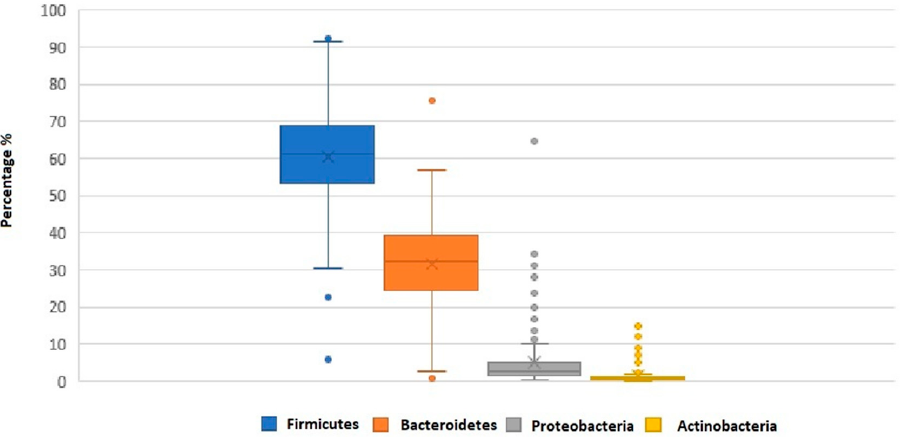
Figure 2. Box plot showing the relative abundance for the dominant phyla determined by the Global Alignment Sequence Taxonomy assignments. The boundary of the box closest to zero indicates the 25th percentile, the line within the box represents the median, and the boundary of the box farthest from zero indicates the 75th percentile. Whiskers above and below the box indicate the 10th and 90th percentiles. The arithmetic mean is indicated by x. Phyla less than 1% of the sequences were not reported. Table 2 shows the differences in the Shannon index, Firmicutes , and Bacteroidetes relative